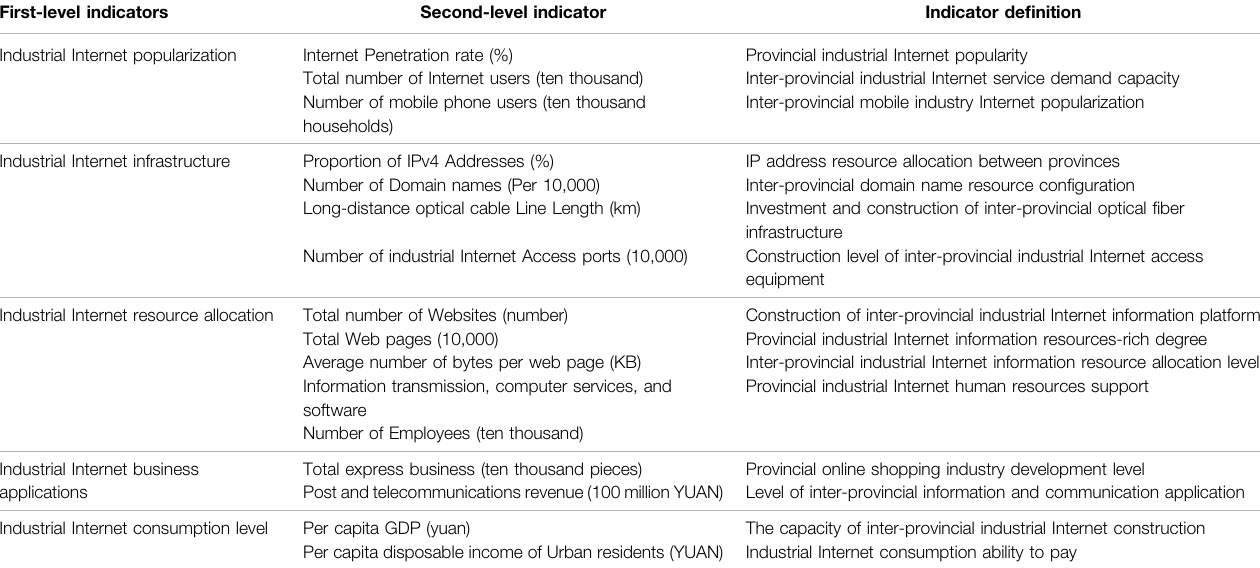
TABLE 1 | Environmental index system of inter-provincial industrial Internet